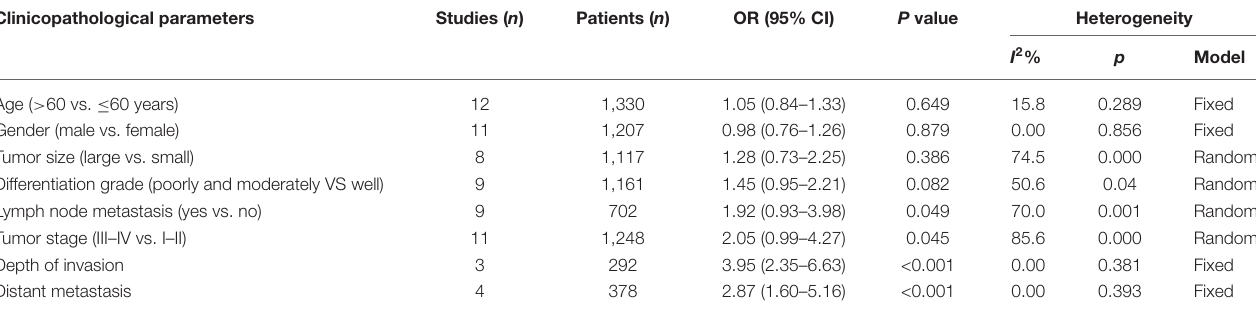
TABLE 3 | Association between lncRNA PANDAR and clinicopathological characteristics of cancer patients. Clinicopathological